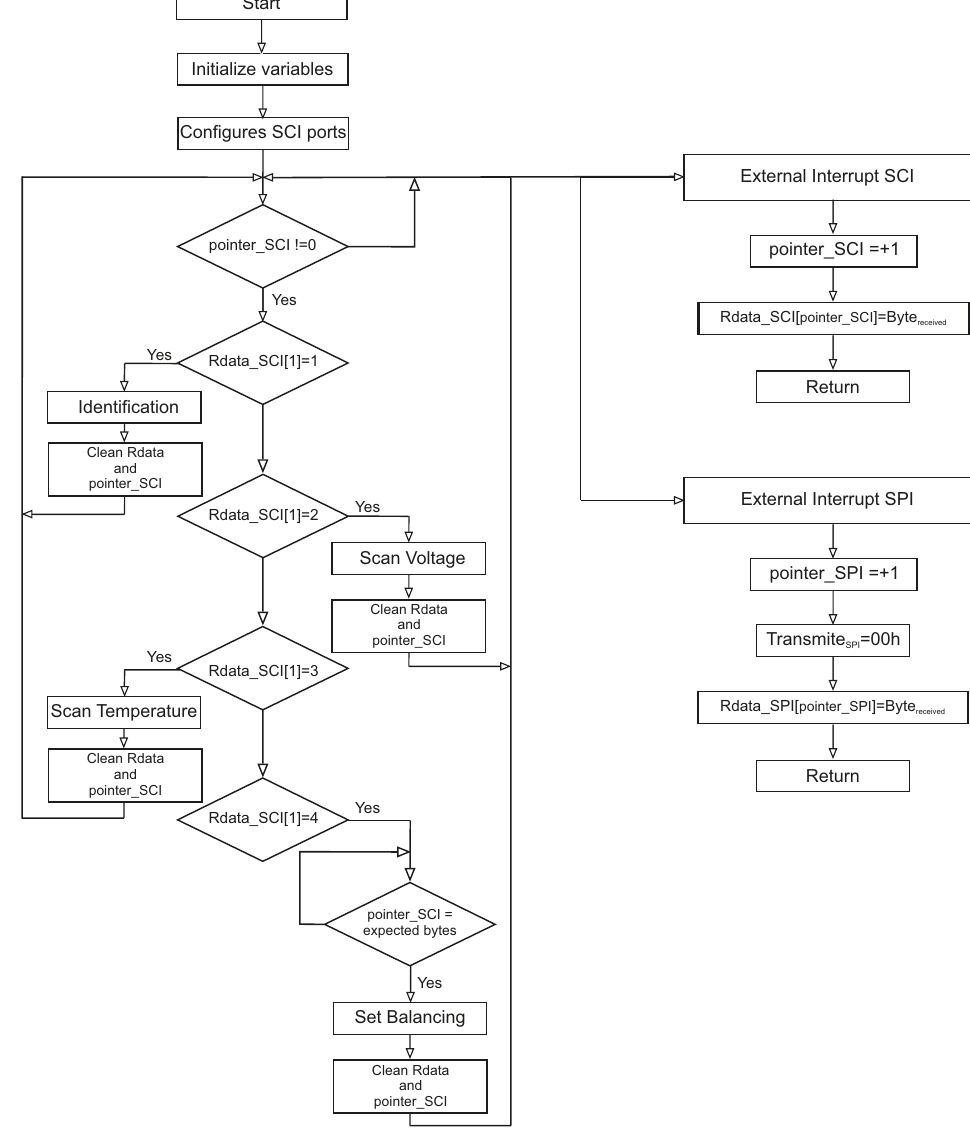
Figure 10. Flowchart of the main program implemented in the auxiliary control unit.